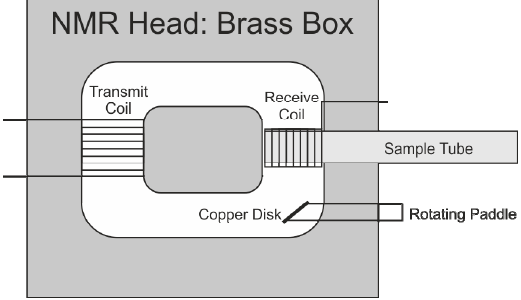
Figure 5. Further coil isolation using a waveguide and physical separation.